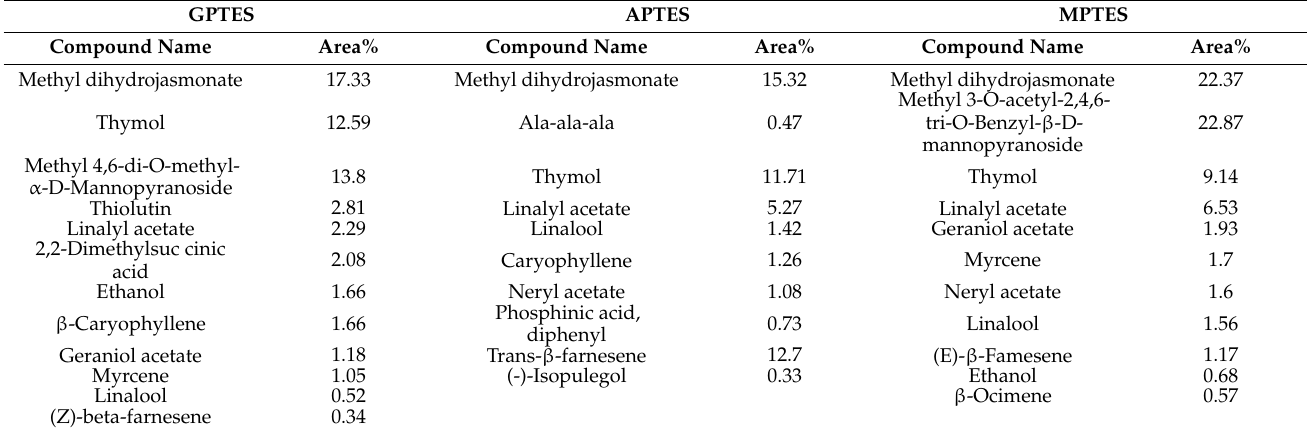
Table 3. Py-GCMS results of different modified EC/SiO 2 fragrance